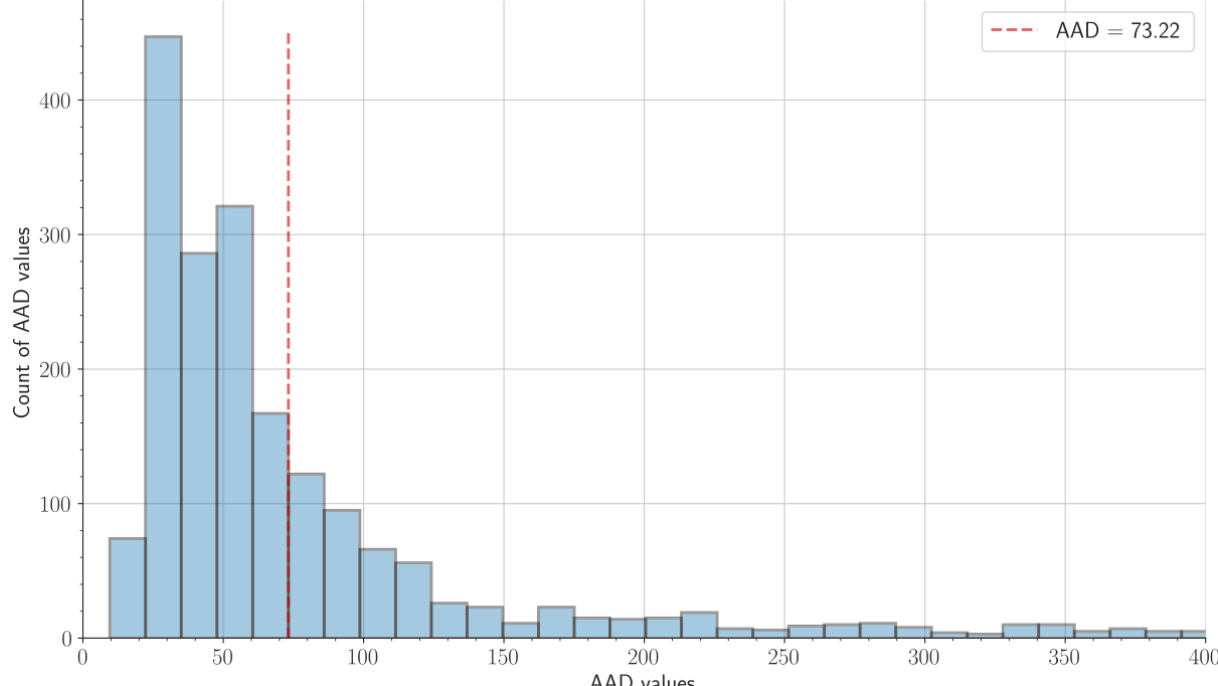
Figure 5. Histogram of the average absolute deviation values for a breathing signal; the gray bars count the average absolute deviation values that fall into each bin. The selected threshold is represented as a red dashed line. The values between 0 and 400 are only displayed to visualize the histogram bins better. AAD: average absolute